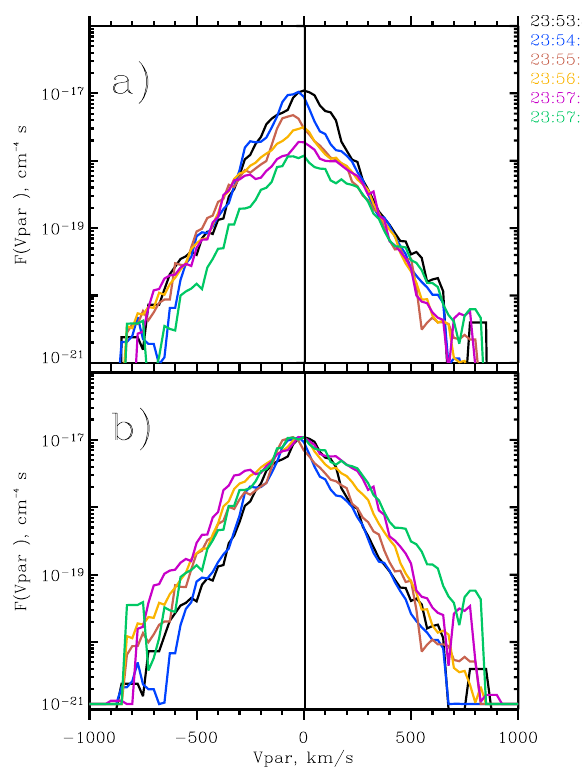
Fig. 9. Six ion velocity distributions (times of measurements are shown to the right) are given within transient at ∼ 23:55UT (top). Bottom: the same velocity distributions normalized to the maxi- mum